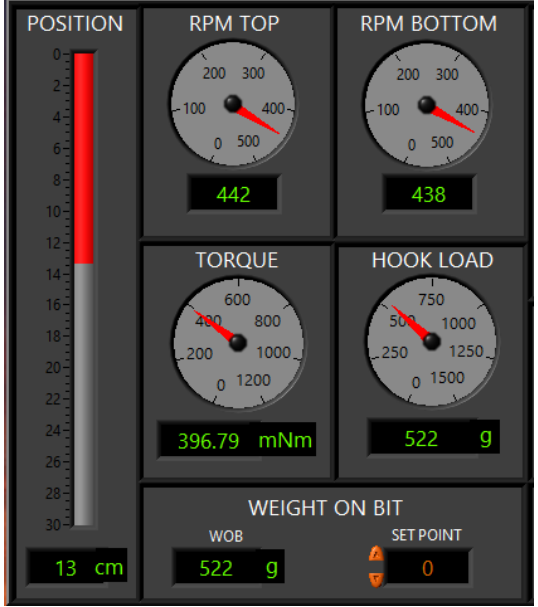
Figure 16. Real-time process parament gauges and indicators.